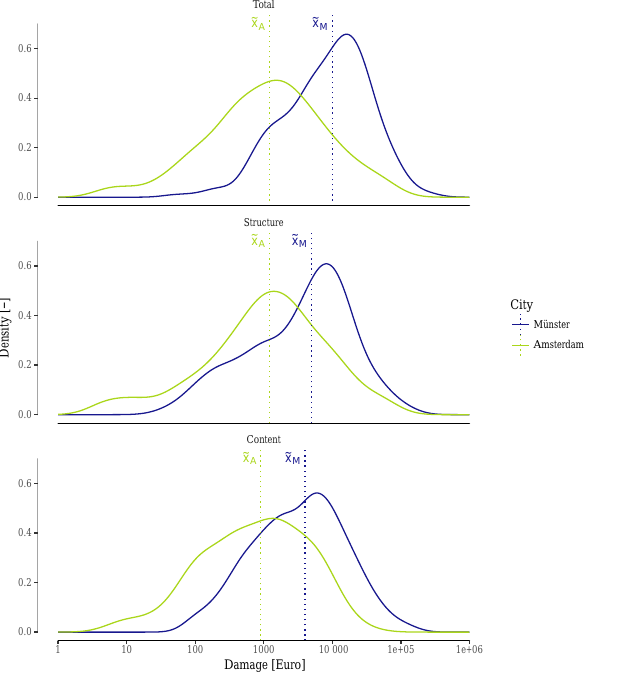
Figure 4. Kernel density function of the total damage (top), the building structure damage (middle) and building content damage (bottom), for Amsterdam (blue) and Münster (green). Zero values are excluded in these graphs. The vertical dashed lines represent the median of the distribution. The difference in medians ( = | x M − x A | ) is significant in all three plots ( p < 0 . 001).